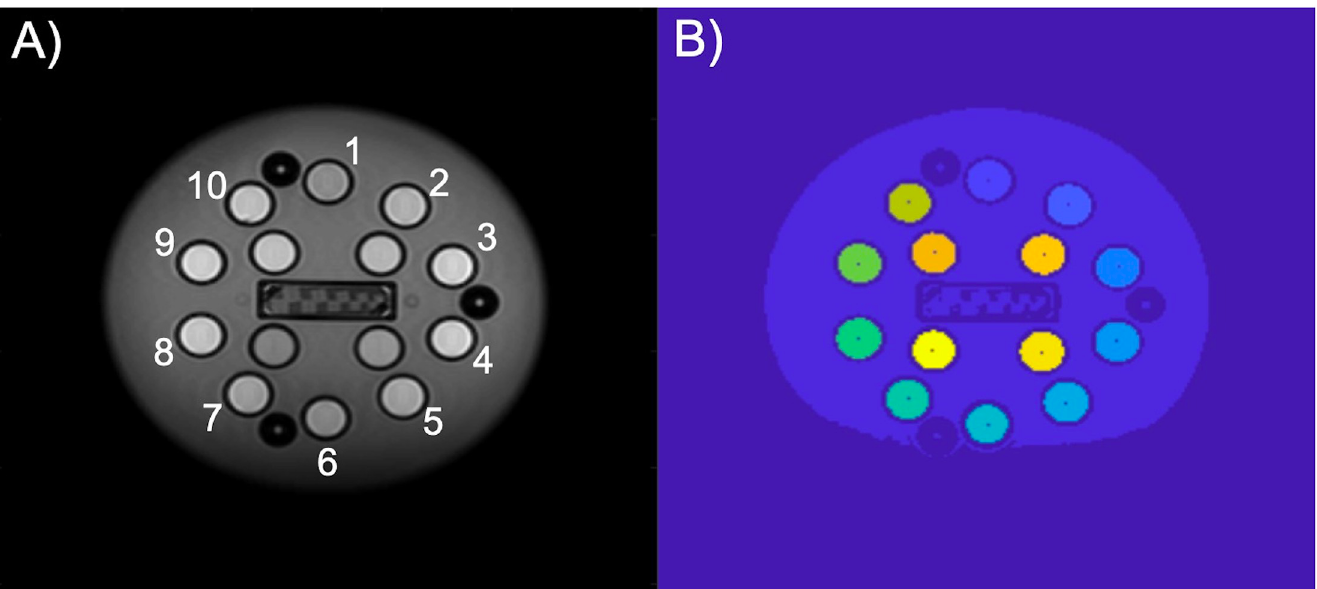
Fig 1. An example coronal slice of the ISMRM/NIST system phantom through the NiCl 2 array and resulting segmentation. (A) The shortest inversion time image used for identification of sample spheres and (B) the segmentation with sample sphere centers identified.